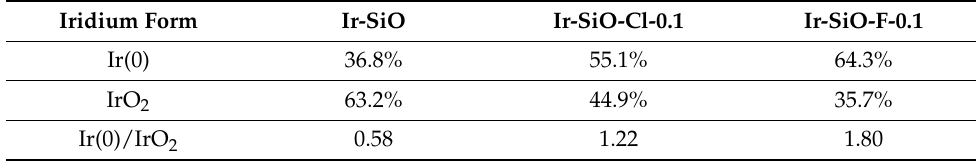
Figure 8. X-ray photoelectron spectra (Ir 4f core levels) for iridium catalysts: Ir-SiO, Ir-SiO-Cl-0.1 and Ir-SiO-F-0.1. Table 4. Ir(0)/IrO 2 ratio determined from XPS analysis.